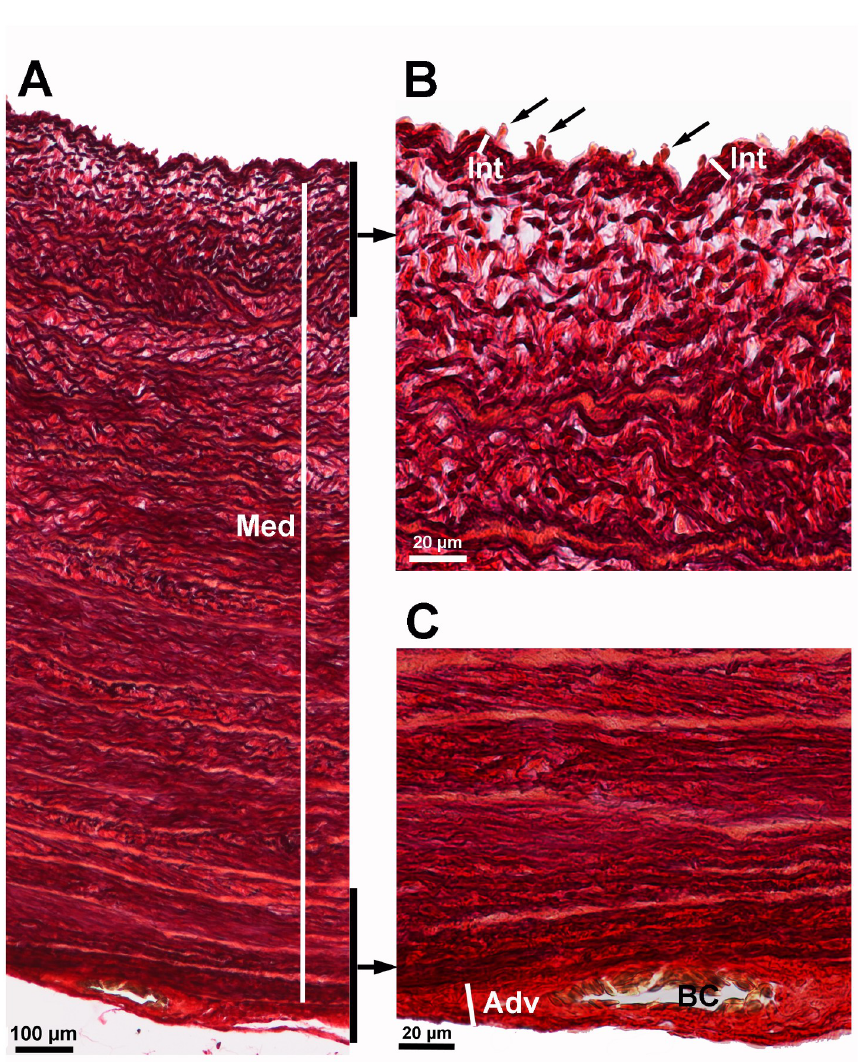
Fig 4. Aortic wall layers of a 35-day-old Lohmann Dual chicken. ( A) entire aortic wall with tunica media (Med), (B) luminal aspect of the aortic wall showing the tunica intima (Int) and endothelial cells (arrows), (C) outer aspect of the aortic wall showing the tunica adventitia (Adv) and blood capillary (BC). Weigert’s Resorcin Fuchsin.